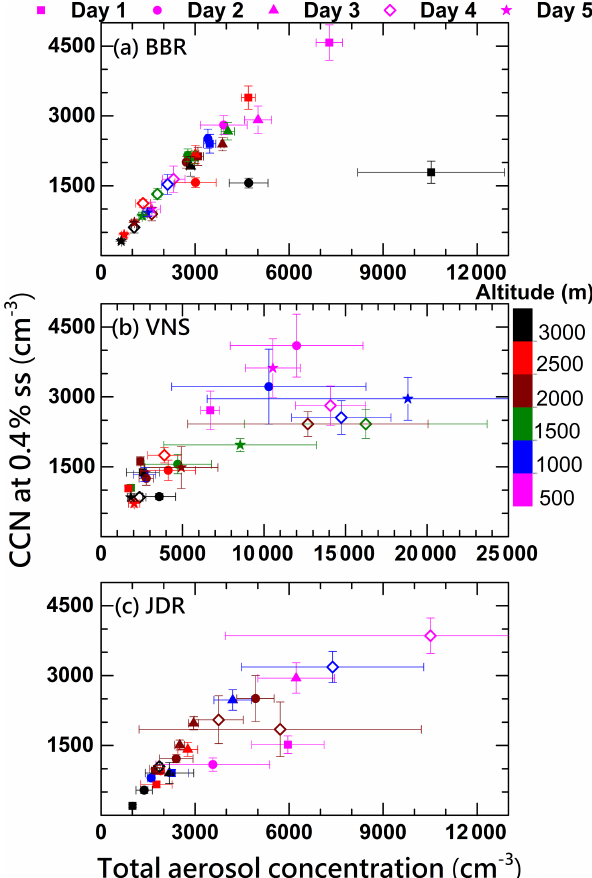
Figure 4. Association between the total CN and CCN number con- centration at 0.4% supersaturation for the (a) eastern IGP (BBR), (b) central IGP (VNS) and (c) western IGP (JDR) for each day of observation at all the observation heights. Colour codes indicate the altitude above ground level, while symbols represent the day of observation. Error bars represent the standard deviation around the mean